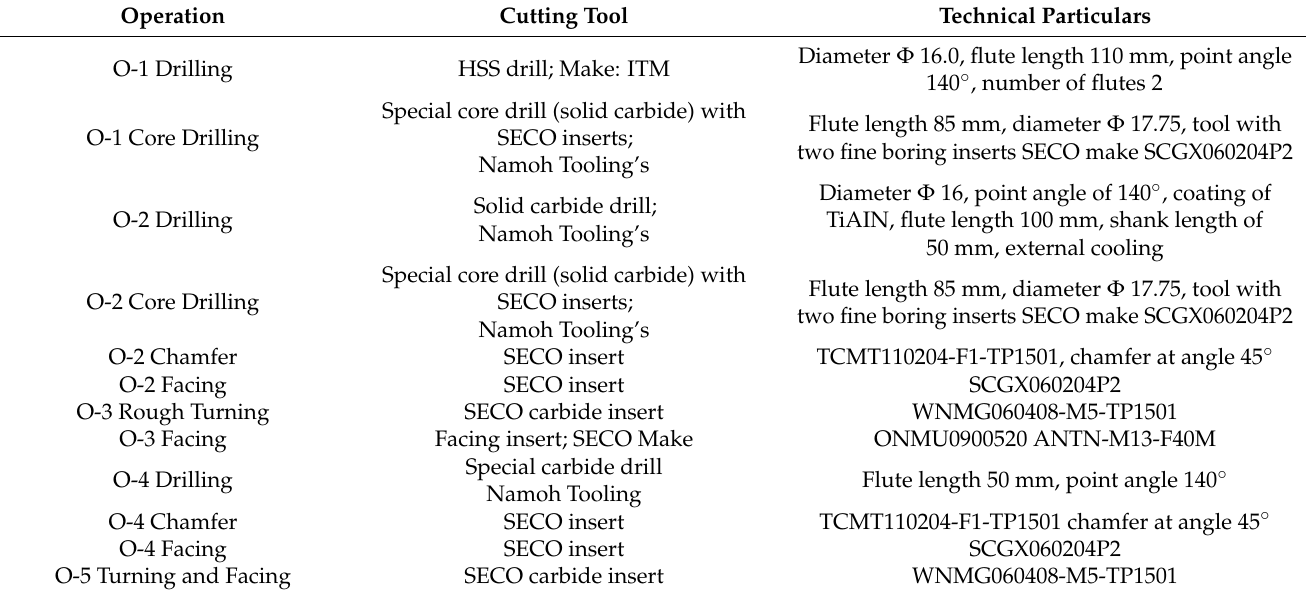
Table 2. Cutting tools, materials, and particulars.